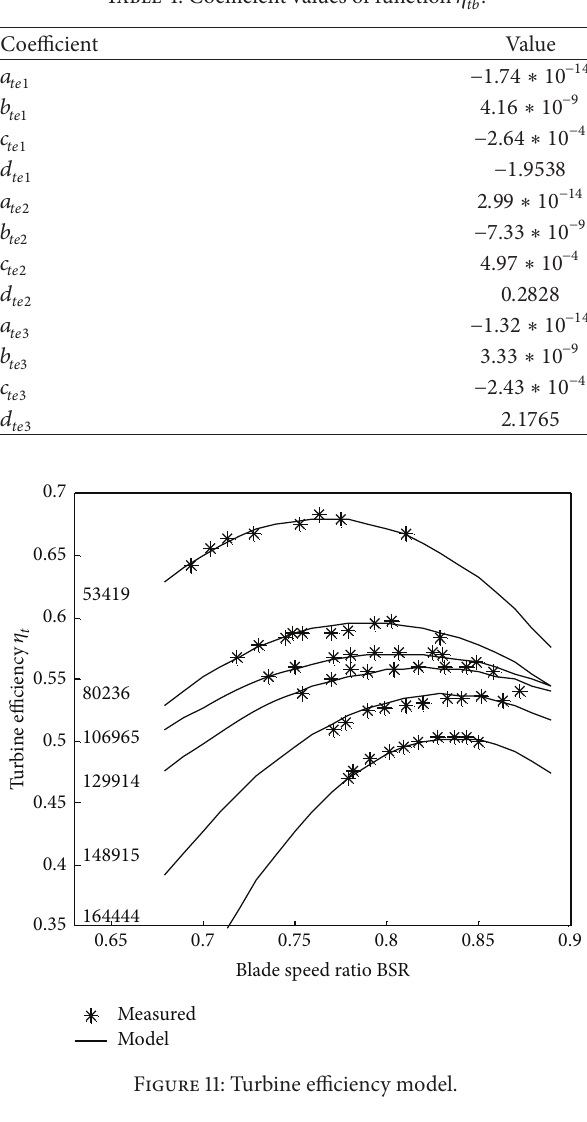
Table 4: Coefficient values of function 𝜂 𝑡𝑏 .